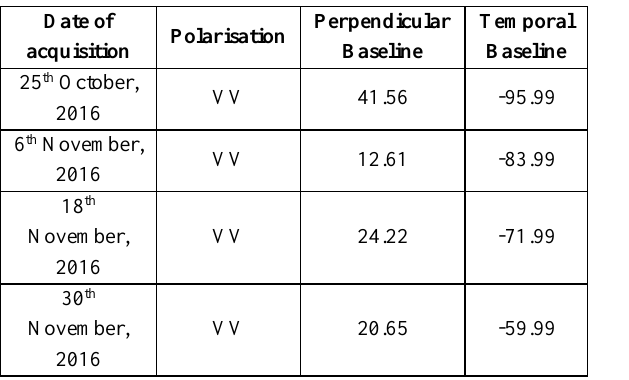
Table 1: Sentinel-1 dataset information